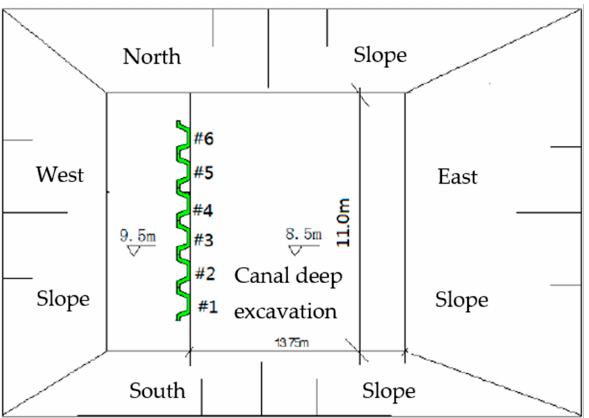
Figure 2. Schematic diagram of deep foundation pit engineering position.